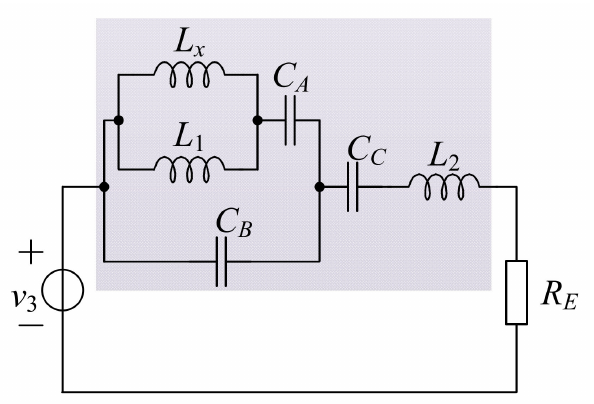
Figure 9. The simplified L x -PS CPT circuit using the T-type model to realize CV